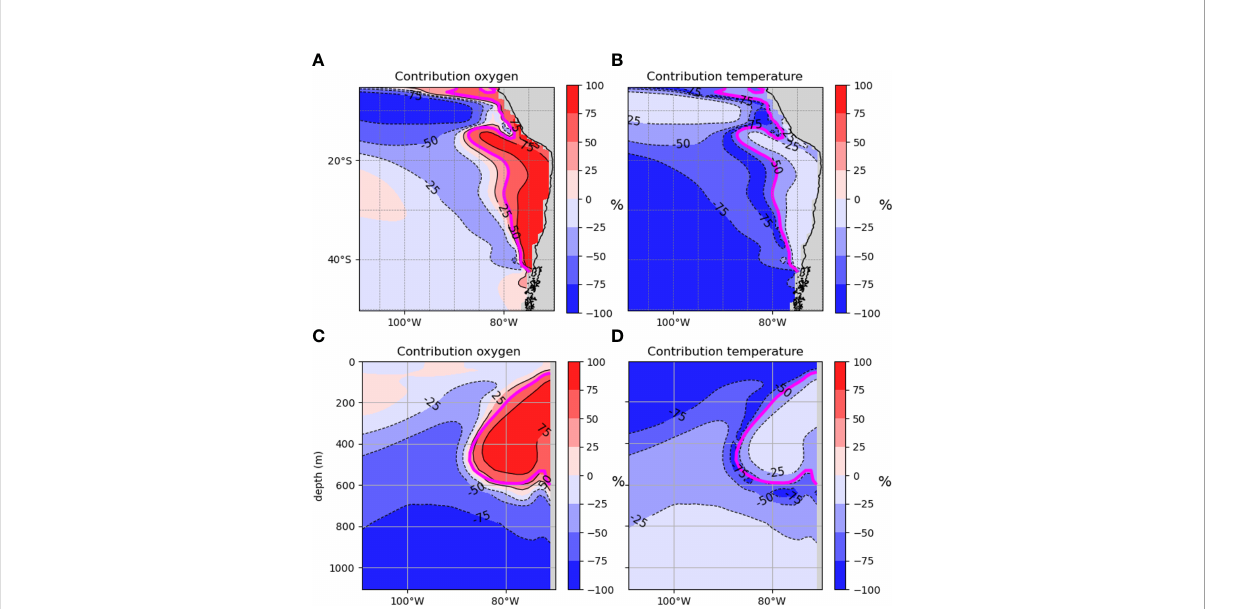
FIGURE 4 Contributions (in %) of the trends in oxygen and temperature to CV Ф of the model species. At 200m (A, B) and 26°S (C, D) . The Eq. 6 of section 2.3.2 is used for this calculation. A negative/positive sign means a negative/positive contribution of the driver. A driver is considered a main driver when % > 75, and O 2 and temperature contribute equally when % = 50. The magenta contour is where [CV]= 0. km.yr -1 signaling the transition area between positive and negative